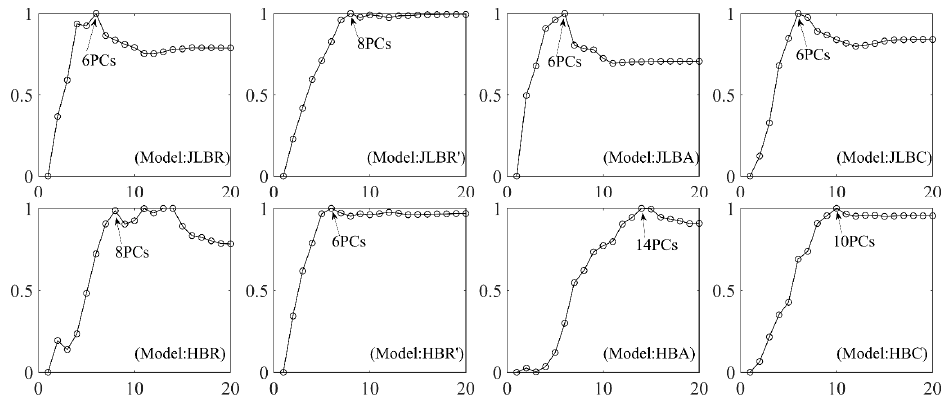
Figure 7. The NRPRs of different numbered PLS components (PCs) of eight benchmark models. As explained in detail in Table 2, the model names in Figure 7 correspond to: JLB: JL Benchmark; HB: HLJ Benchmark; R, R’, A and C in model names correspond to four forms of spectra.